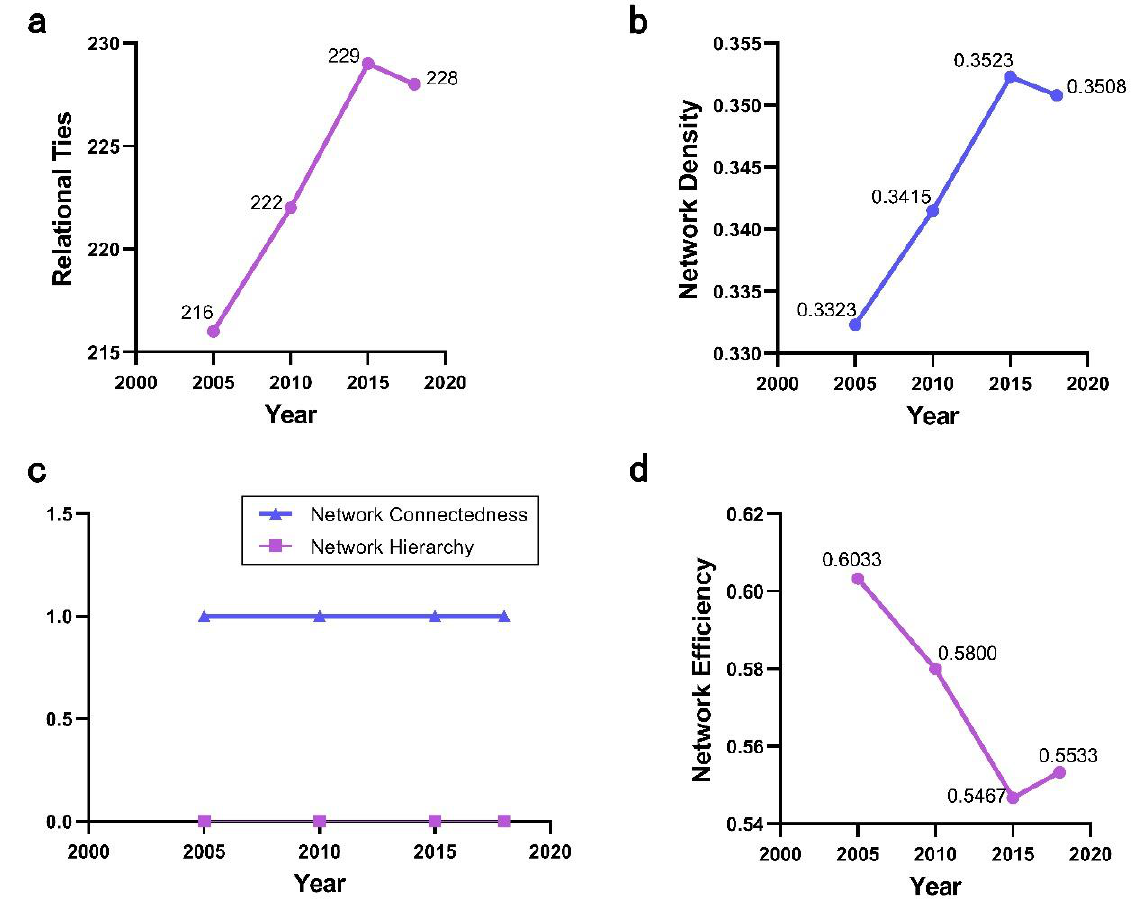
Figure 6. Whole network analysis of CO 2 emissions in the YRDUA’s cities: ( a ) relational ties; ( b ) network density; ( c ) network connectedness and network hierarchy; ( d ) network efficiency.